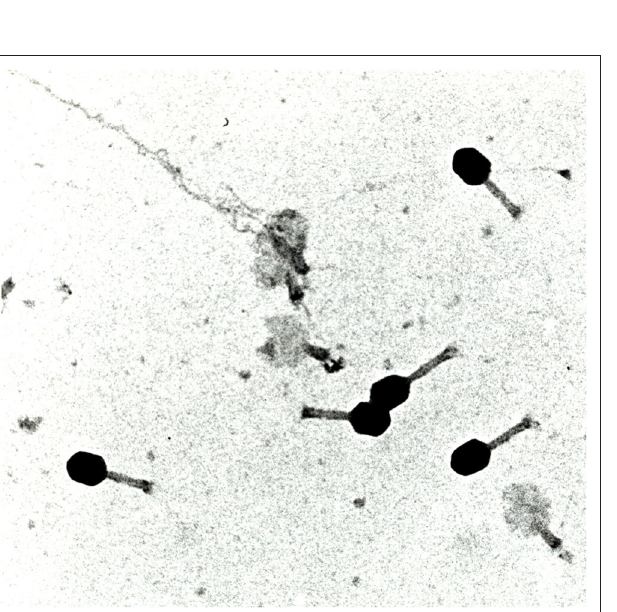
FIGURE 3 | Images of radiation-induced damage in virus. The photo shows the bacteriophage T4 irradiated with protons (details in Ref. [25]). Black heads retain the DNA, and white heads have lost the molecule, which is seen flowing out of the envelope in some viruses. Electron microscope photograph from the Tandem accelerator of the University Federico II, Naples, Italy, courtesy of Prof. Gianfranco